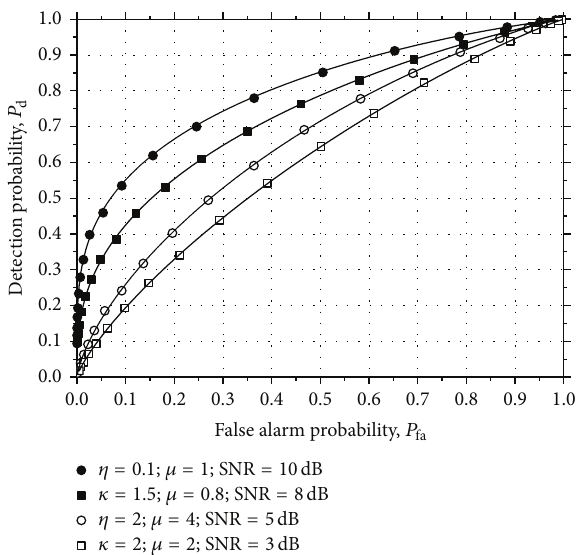
Figure 11: ROC curves for 𝜅 - 𝜇 and 𝜂 - 𝜇 with different values of 𝜅 , 𝜂 , and 𝜇